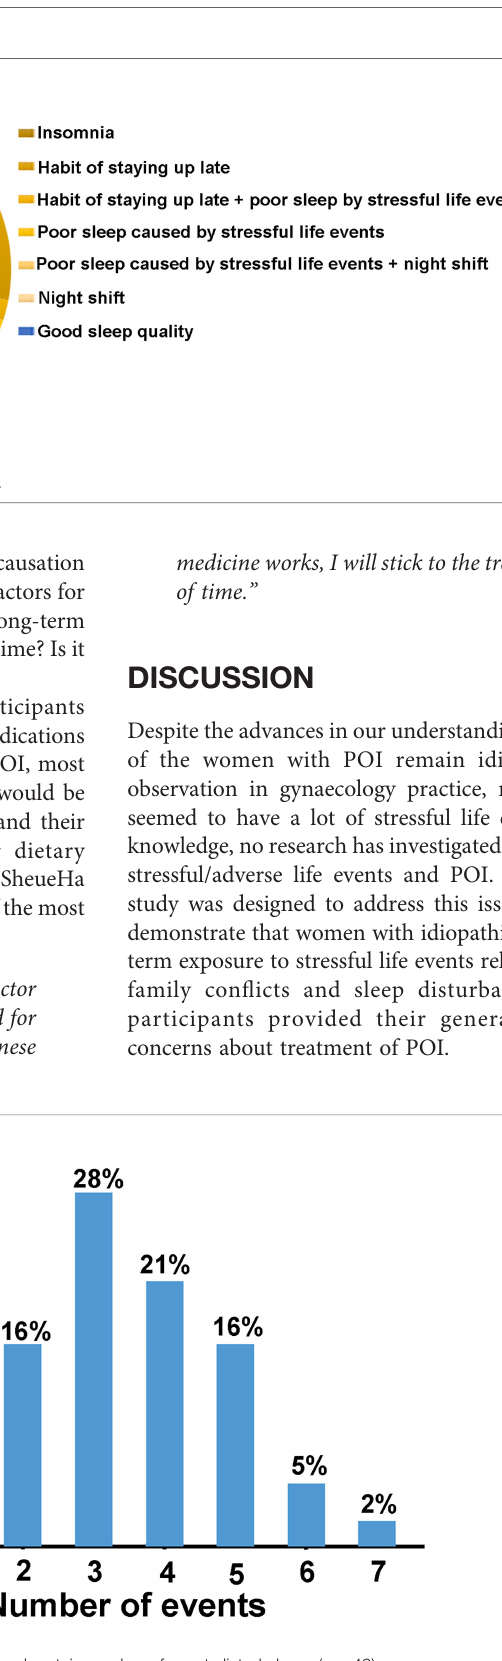
FIGURE 3 | The percentage of women with POI who have experienced certain number of events listed above (n = 43).